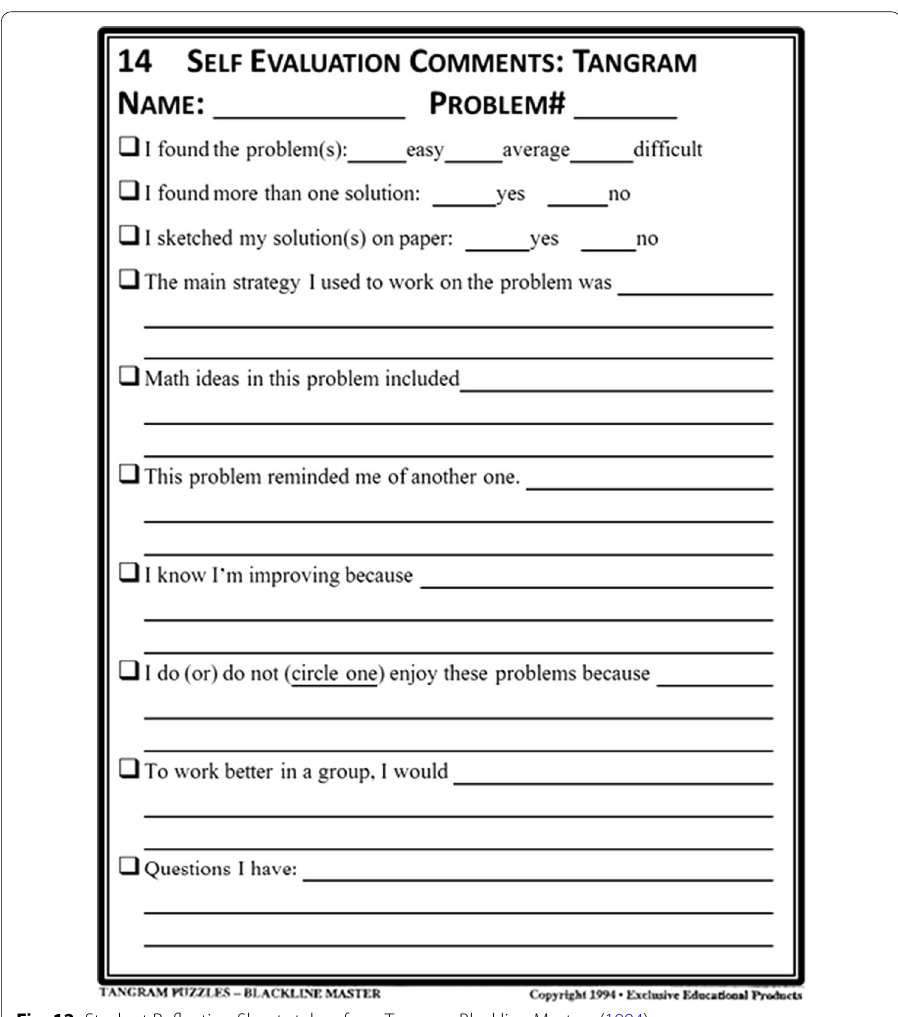
Fig. 12 Student Reflection Sheets taken from Tangram Blackline Masters